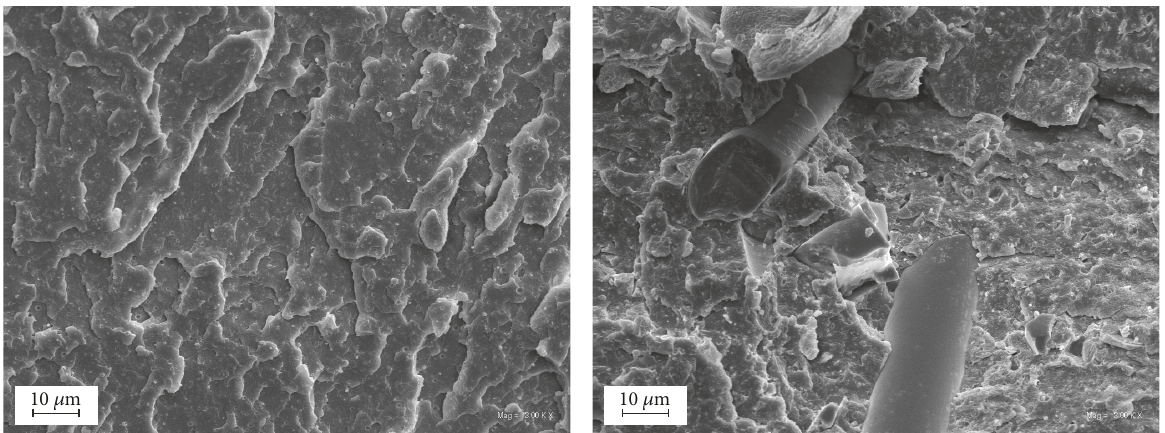
Figure 13: SEM images of cryogenic fracture of PVC (left) and PVC/5% GFCD composite